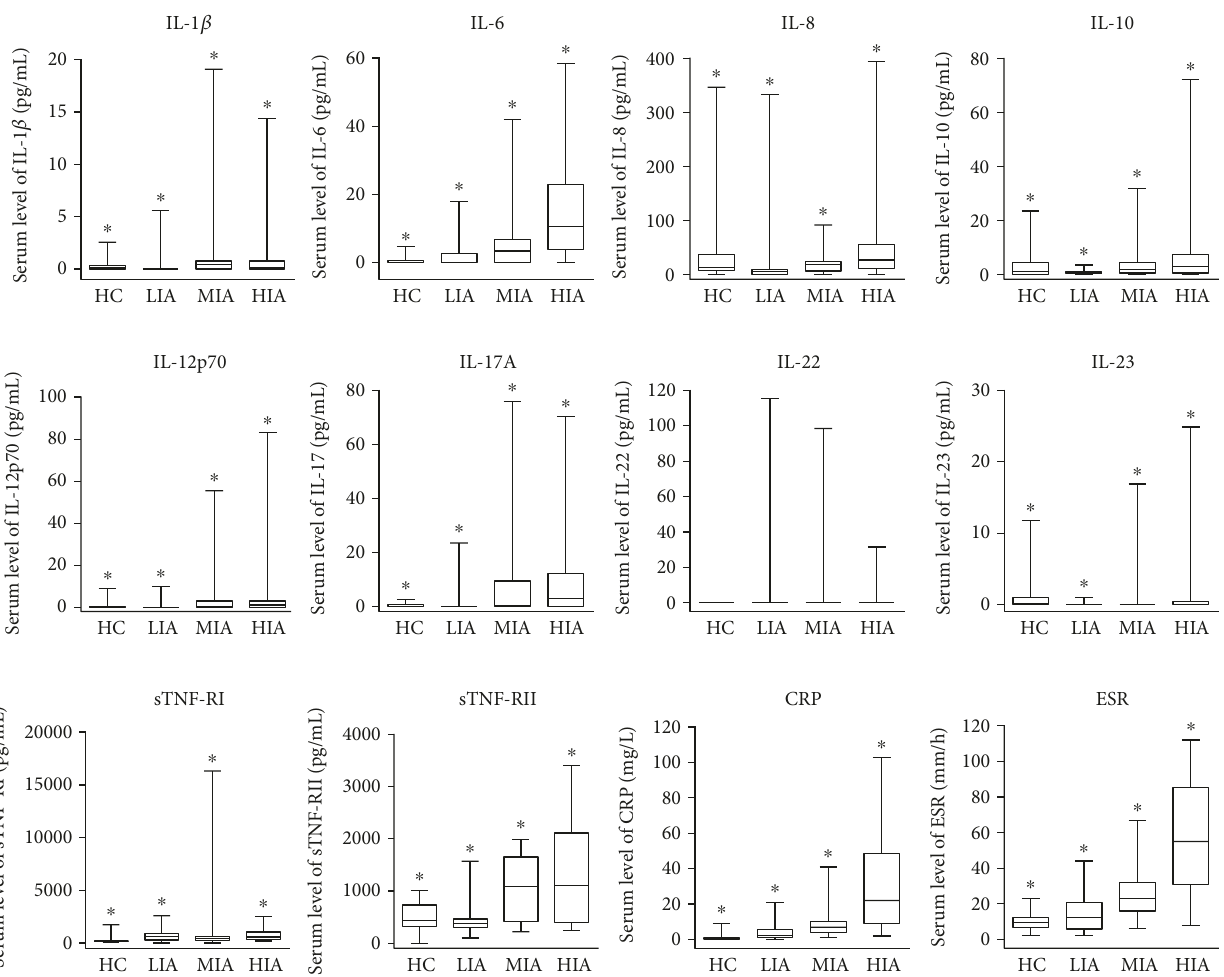
Figure 1: Comparison of in fl ammatory serum marker levels among healthy controls and patients with hidradenitis suppurativa according to clinical in fl ammatory activity. IL, interleukin; CRP, sTNF-RI, soluble TNF receptor I; sTNF-RII, soluble TNF receptor II; C-reactive protein; ESR, level erythrocyte sedimentation rate; HC, healthy controls; LIA, low in fl ammatory activity; MIA, moderate in fl ammatory activity; HIA, high in fl ammatory